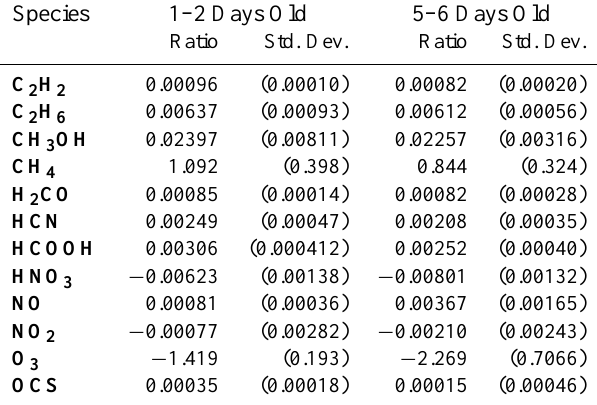
Table 2. Age comparisons of Canadian Boreal plumes from July 2010 listing the enhancement factor relative to CO ([ 1 X]/[ 1 CO]), for plumes 1–2 and 5–6 days old with the associated 1-sigma stan- dard deviation. Calculations were made from approximately 15 oc- cultations ( n = 60) of plumes from each representative age. Ratios for the primary pyrogenic species relative to long-lived CO decrease over time as these species are destroyed mainly by reaction with OH as the plume ages, negative correlations are noted for O 3 , NO 2 and HNO 3 indicating destruction processes.